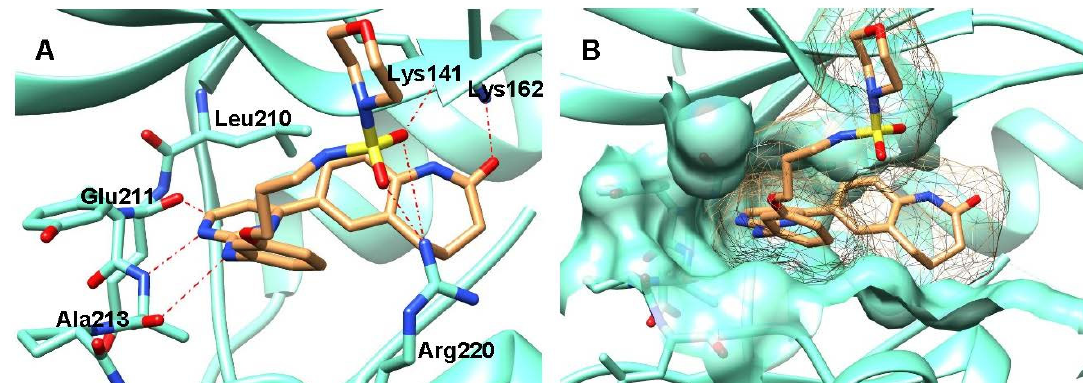
Figure 5. Docking result of 14b in the ATP binding pocket of Aurora A Kinase (PDB 7AYH). ( A ): Hydrogen bonds are formed between Glu211 and the CH group of the pyrimidine ring (D–A = 2.59 Å), between the aniline NH group and Ala213 (D–A = 3.17 Å) and between the pyrimidine nitrogen atom and Ala213 (D–A = 2.54 Å). There is also a hydrogen bond between the carbonyl group of benzazepin-2-one and Lys162. The sulfonyl group interacts with the amino acids Lys141 and Arg220. ( B ): Surface representation of the ATP-binding pocket and ligand 14b .